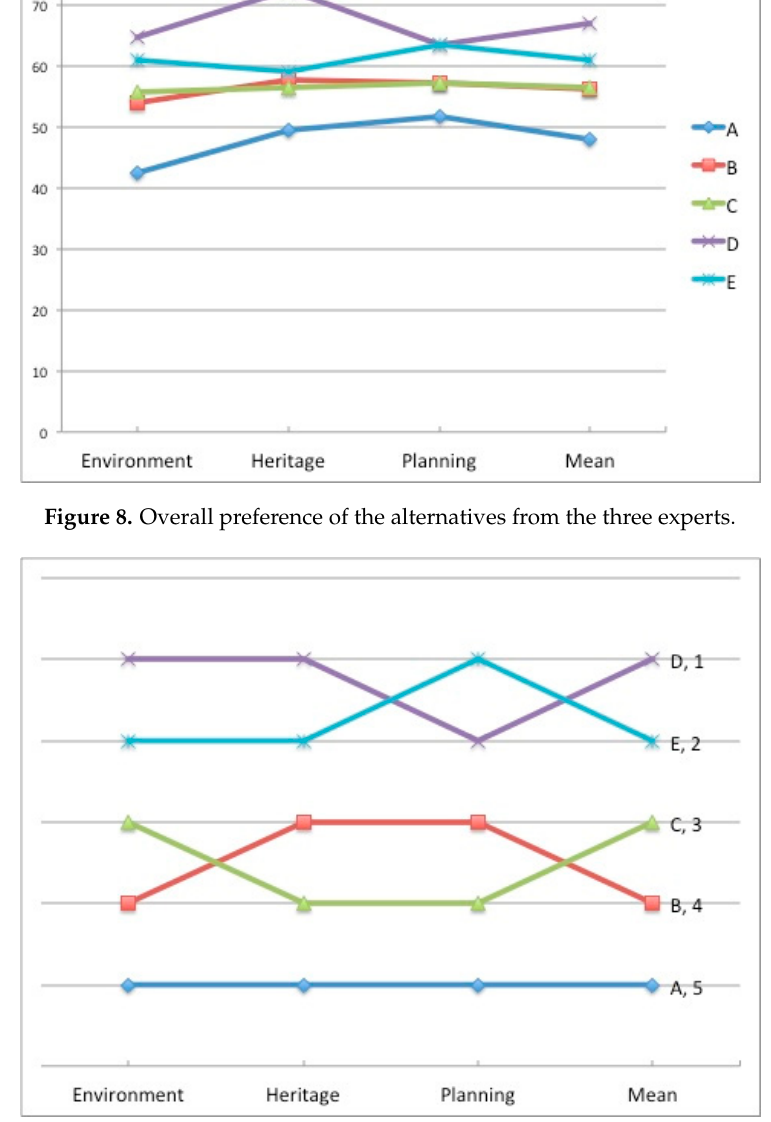
Figure 9. Overall ranking order of the alternatives from the three experts.